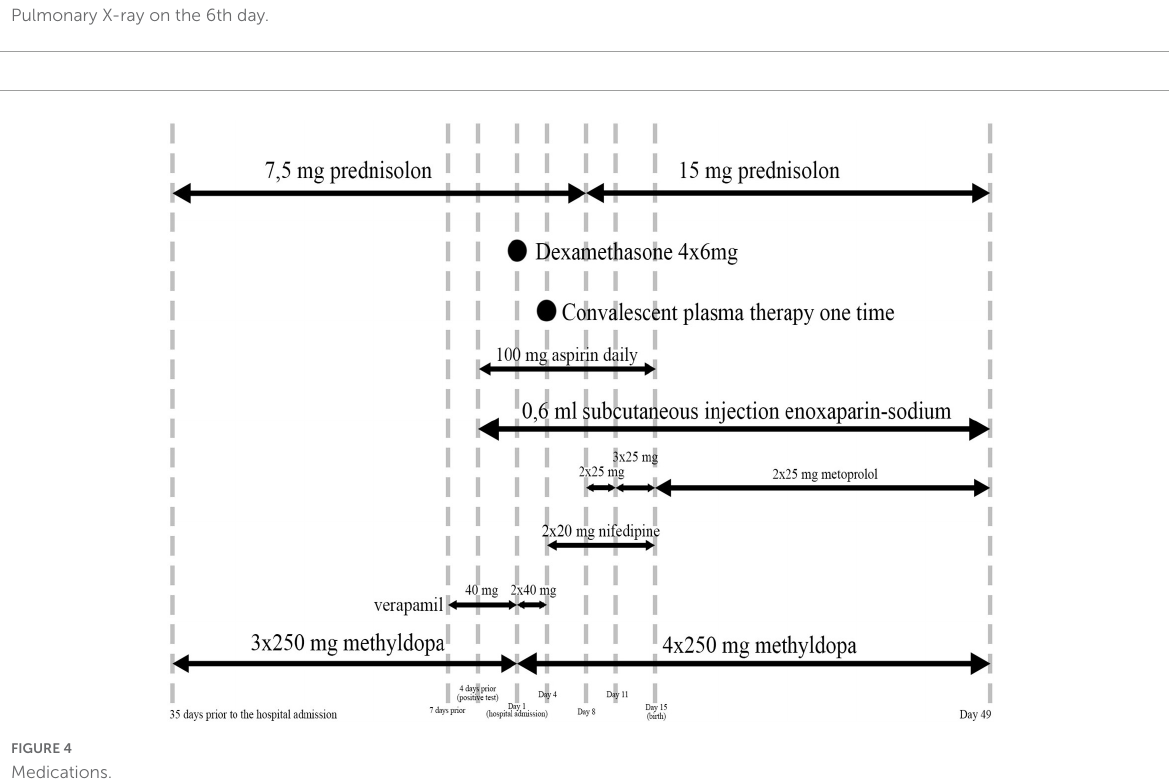
FIGURE3 Pulmonary X-ray on the 6th day.